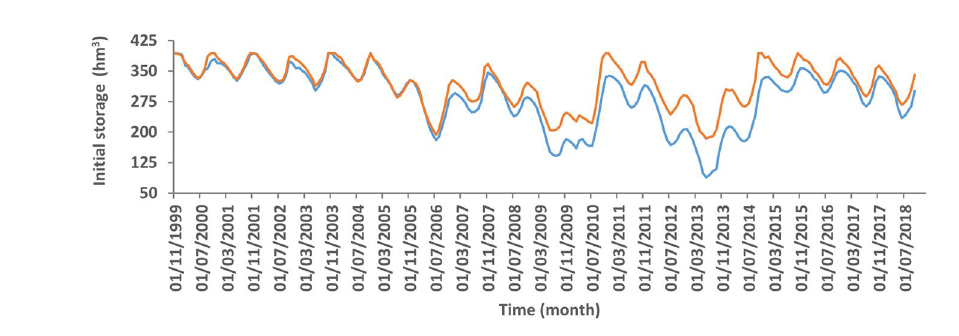
Fig. 19 The monthly initial storage values of the Victoria Valley reservoir with GA2 and GA3 policy